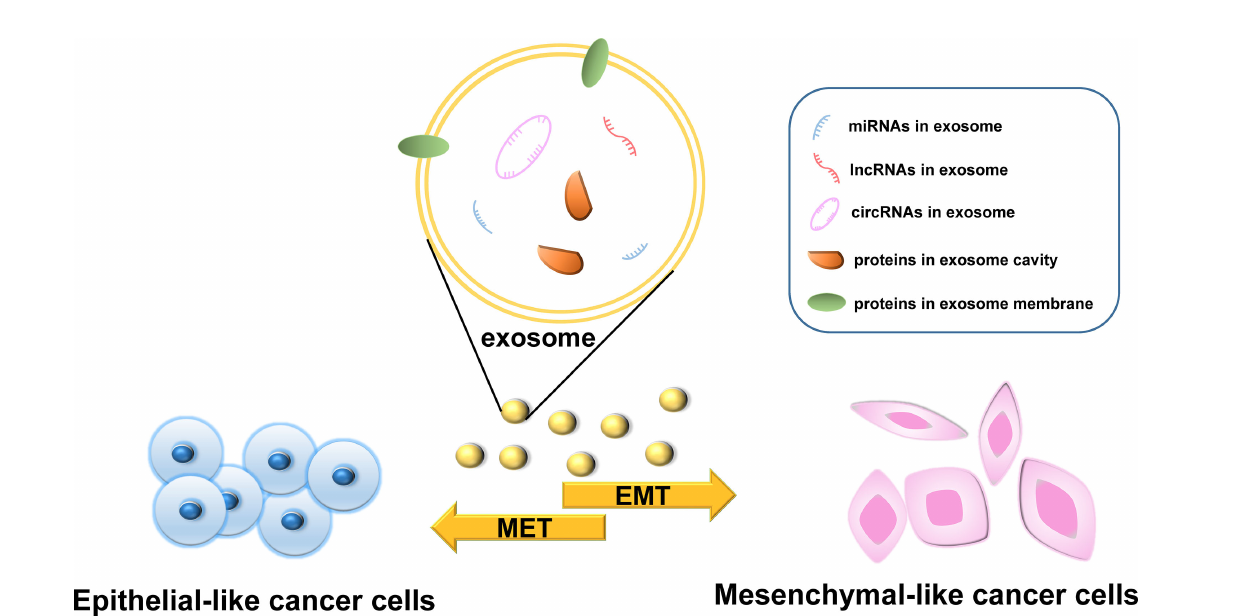
FIGURE 2 | The effects of molecules carried by exosomes on epithelial – mesenchymal transition (EMT).